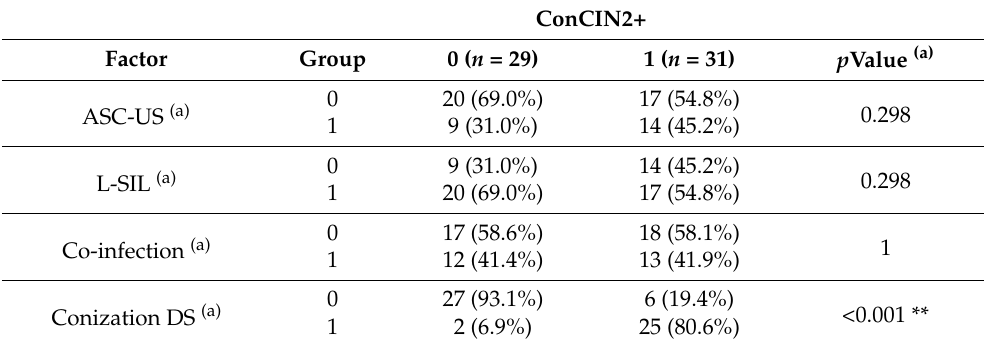
Table 3. Cont. (b). Crosstabulation of CIN2+ and ASC-US, L-SIL, co-infection (i.e., more than one strain of HR-HPV present), and dual-staining on the conization piece (conization DS).